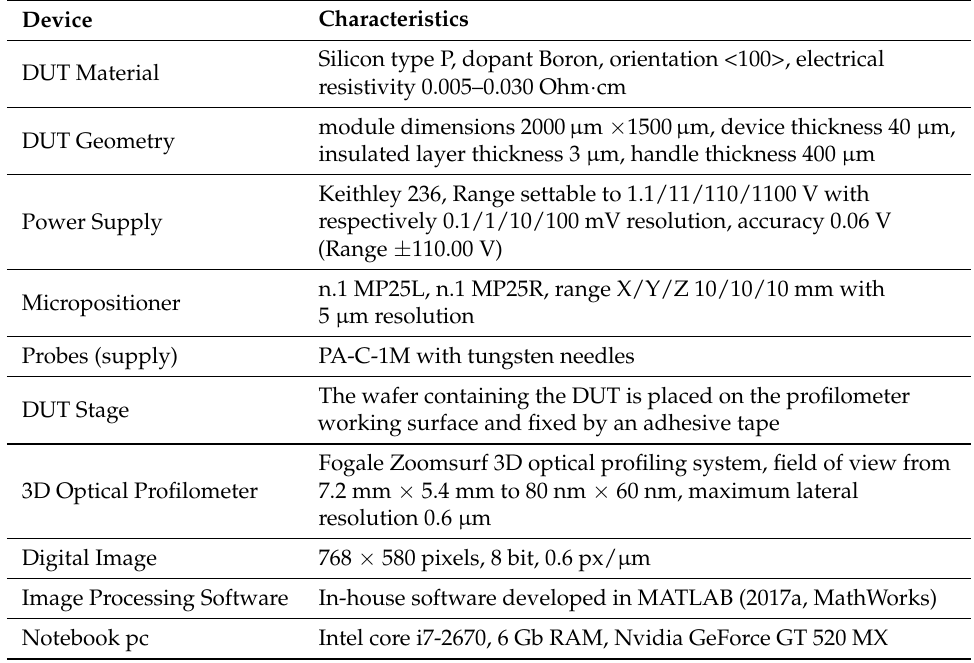
Table 1. Optical Profilometer System (OPS) experimental setup: specifications of the comb-drive actuated silicon microgripper (Device Under Test, DUT) and of the testing stand.